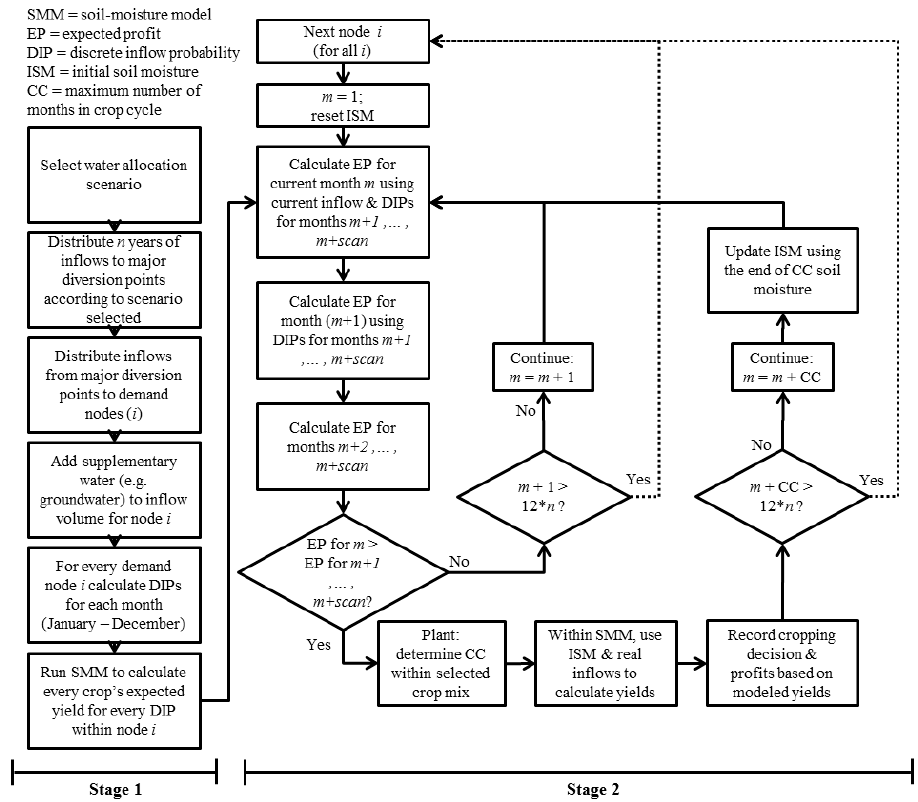
Figure 2. Integrated model applied to all “ i ” irrigation command areas. Stage 1 prepares the model inputs for each command area; stage 2 simulates agronomical decisions and processes over time for each command area. The integrated simulation is run over a multi-year planning horizon (e.g., historical inflows) and a n -month “scan” period (Section 4) over which the famer makes seasonal cropping decisions.